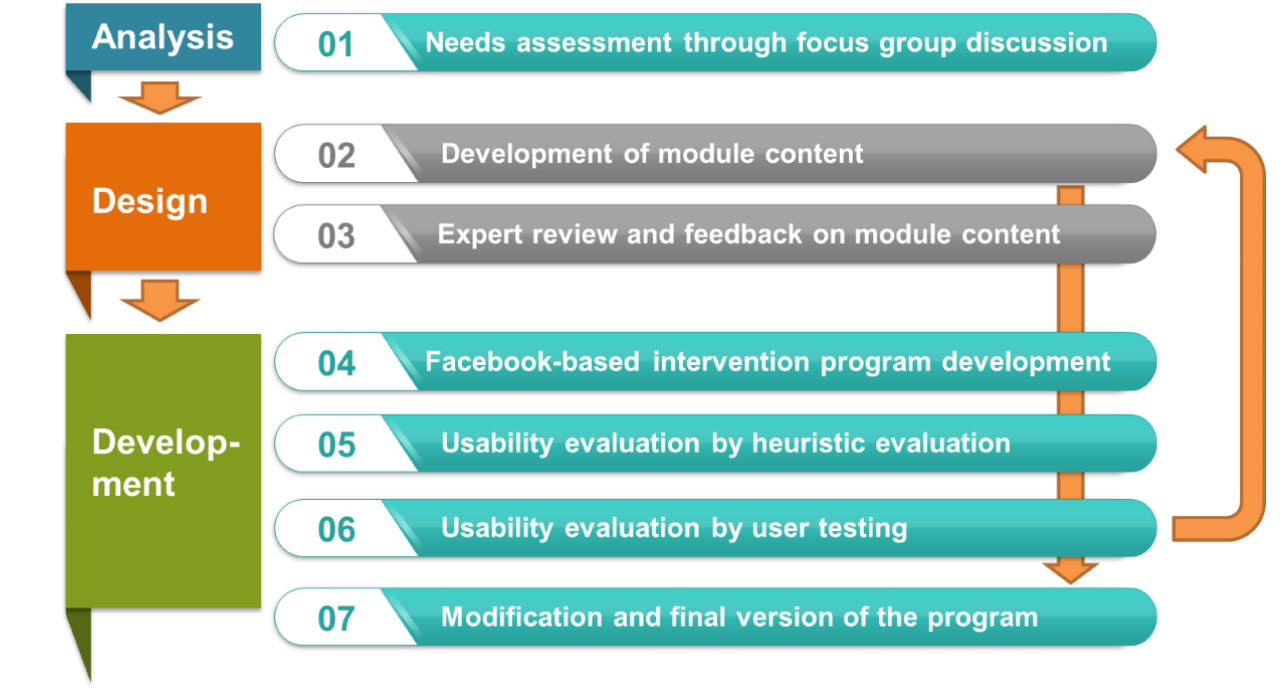
Figure 1. Flow chart of "Healthy Teens for Soaam" program